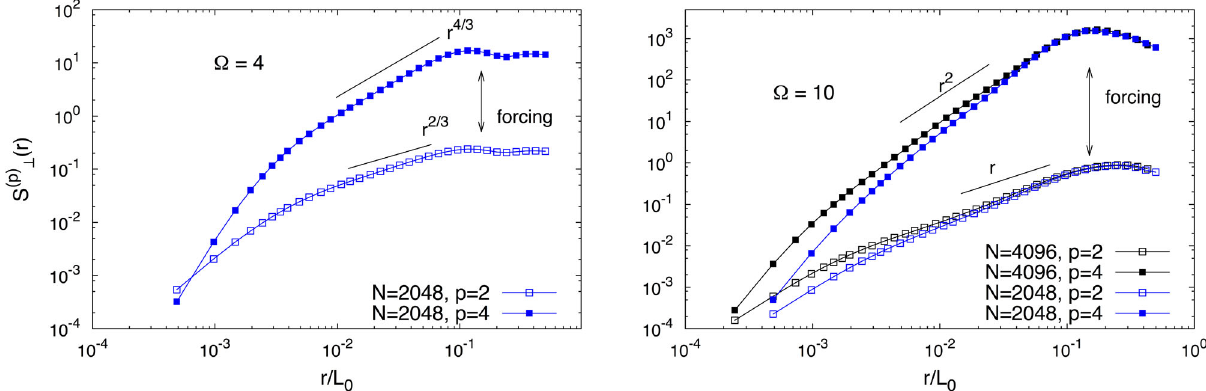
2 Þ r Þ and fourth-order S ð 4 Þ r Þ Eulerian transverse structure functions. Left: Case with N ¼ 2048 FIG. 5. Log-log plot of the second- S ð ⊥ ð ⊥ ð and Ω ¼ 4 . The dimensional scaling predictions ∝ r p= 3 according to the K41 isotropic scaling are also plotted. Right: Case with